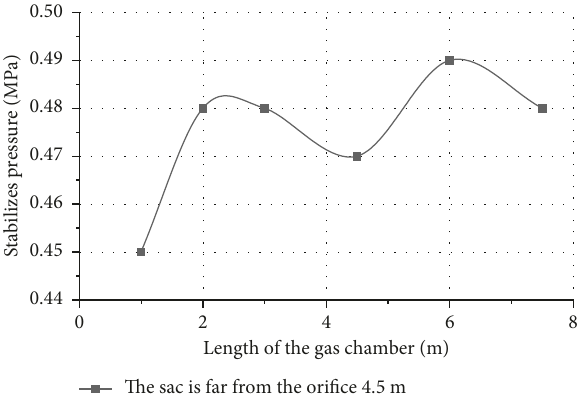
Figure 13: Effect of air chamber length on stable pressure when the sealing section is 4.5m from the orifice.